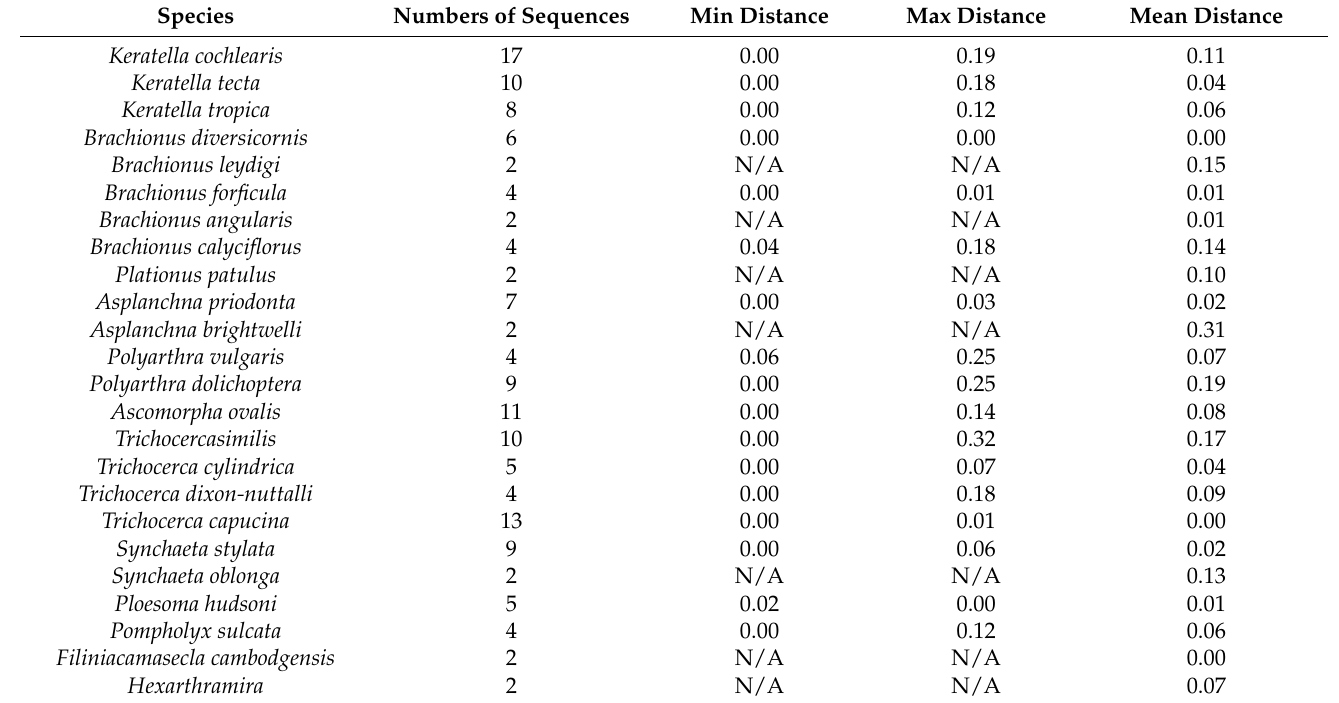
Table 2. Intraspecific genetic distance (K2P) of 24 rotifer species.